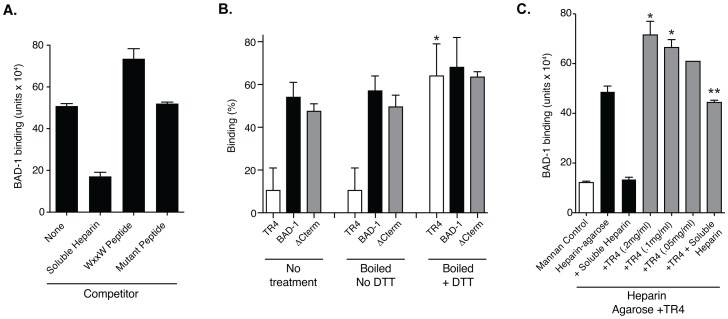
Influence of competitors on BAD-1 binding to heparin.
(A) Effect of a WxxW motif heparin-binding peptide on binding of BAD-1 (eFluor605) to immobilized heparin. “None” denotes BAD-1 binding to heparin agarose with no competitor. The WxxW peptide, or a mutant control peptide, was incubated with heparin resin at 1 mg/ml before addition of fluorescent BAD-1. Binding was quantitated by fluorescence units detected in a Filtermax F5 plate reader. Results are the mean ± SEM two experiments. (B) Effect of TR4 reduction on binding to heparin. Samples were incubated with resin directly or first boiled for 3 min in buffer alone or buffer with 5 mM DTT. TR4 has four copies of the BAD-1 tandem repeat. ΔCterm has all 41 repeats, but no C-terminal EGF-like domain. Binding was quantified by A280 measurement. Reduced TR4 bound significantly better than untreated TR4 or TR4 boiled without DTT (*, p<0.05). Results are the mean ± SEM of two experiments. (C) Effect of reduced TR4 on binding of BAD-1 (eFluor605) to immobilized heparin. BAD-1 binding to heparin agarose was quantified with or without pretreatment of resin with reduced TR4 as in panel C. BAD-1 binding was quantified by fluorescence units as above. Mannan resin is a background control. Heparin resin pre-treated with reduced TR4 at 0.2 and 0.1 mg/ml bound BAD-1 significantly better than untreated heparin resin (*, p<0.05). Soluble heparin significantly blocked binding of BAD-1 to both of these pre-treated resins (**, p<0.05).